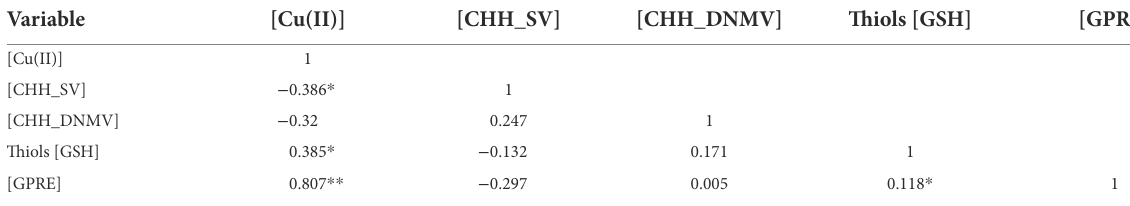
TABLE 3 Pearson’s linear correlation coefficients for analyzed variables.